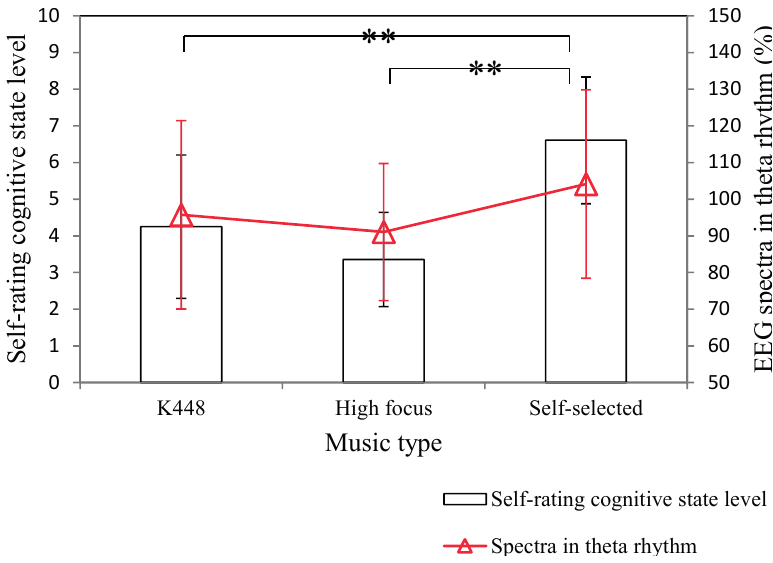
Figure 7. Self-rating cognitive state level and EEG spectra in theta rhythm corresponding to different music types. Here, ** denotes